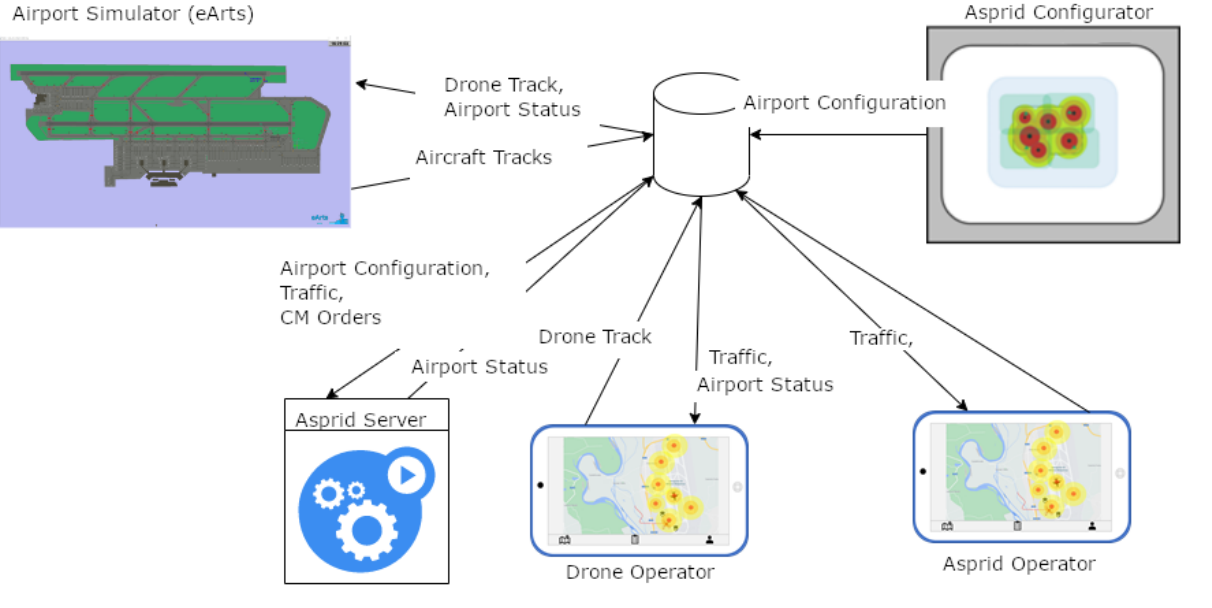
Figure 8. Architecture of the simulation platform.